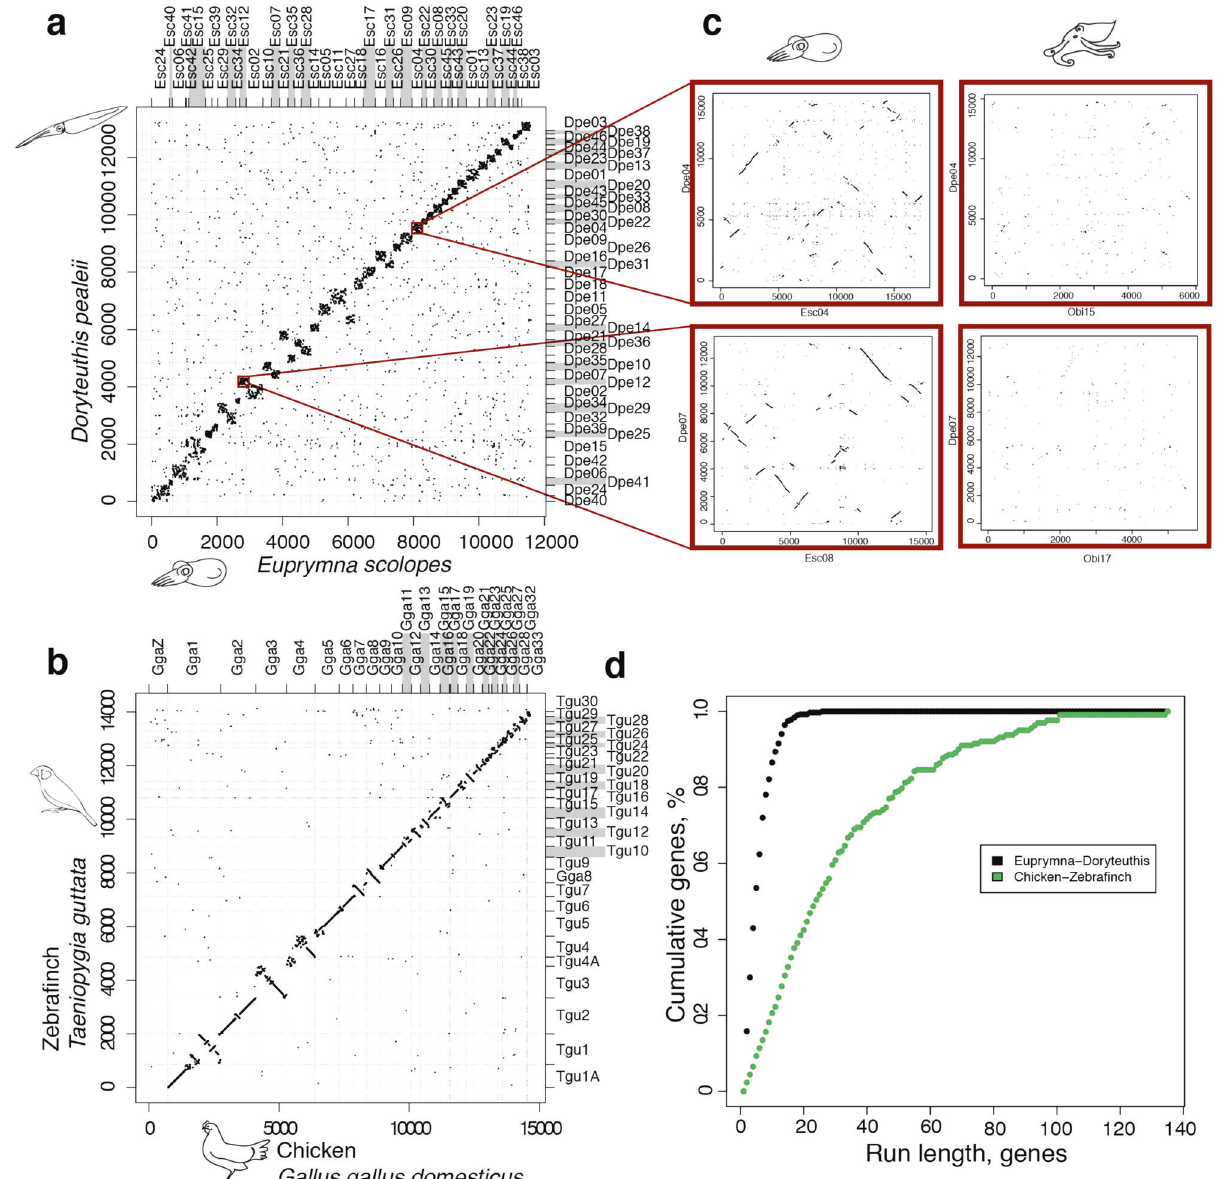
Fig. 4 Disruption of colinearity in squid, but not bird, genomes. Mutual best hit dotplots between squids ( a ) and birds ( b ). c Megablast alignment in 10 kb windows of E. scolopes and D. pealeii (left) and O. bimaculoides and D. pealeii (right). The squid show some retention of colinearity while colinearity is lost between octopus and squid genomes. d Quanti fi cation of microsyntenic cluster sizes. Run length corresponds to the number of genes in a detected microsyntenic linkage (maximum number of intervening genes = 5), and cumulative genes (y-axis) corresponds to the total sum of genes in the run of a certain size or larger. This allows us to de fi ne an “ N50 ” measure: 50% of squid genes are in microsyntenic runs of 4 or fewer genes and 50% of bird genes are in microsyntenic runs of 23 or fewer